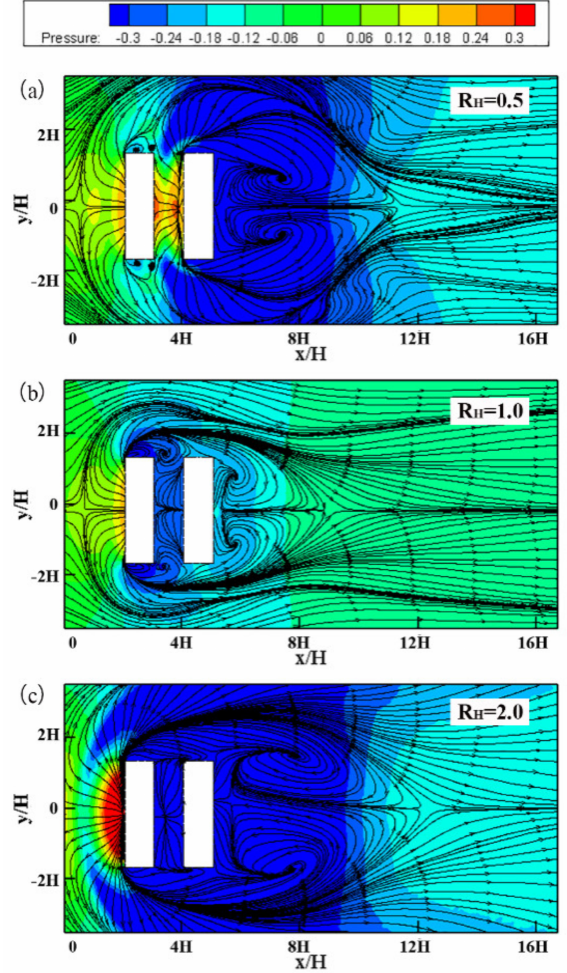
Figure 14. Time-averaged streamlines and flow velocity contours on the horizontal plane (z = 0) of streets with different height ratios: ( a ) R H = 0.5; ( b ) R H = 1.0; ( c ) R H =